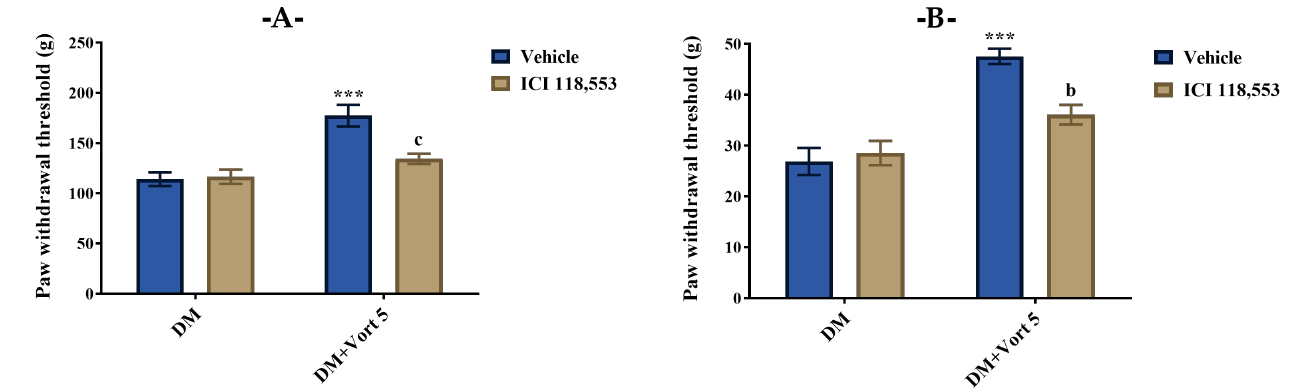
Figure 8. The effects of ICI 118,553 pre-treatment on antihyperalgesic ( A ) and antiallodynic ( B ) responses induced by the administration of 5 mg/kg vortioxetine in the Randall–Selitto and Dynamic plantar tests, respectively. Values are given as mean ± S.E.M. Significant difference against vehicle-administered diabetic group (DM) *** p < 0.001; significant difference against vortioxetine- administered diabetic group (DM+Vort 5) b p < 0.01; c p < 0.001. Two-way ANOVA, post hoc Bonferroni multiple comparison test, n = 8.